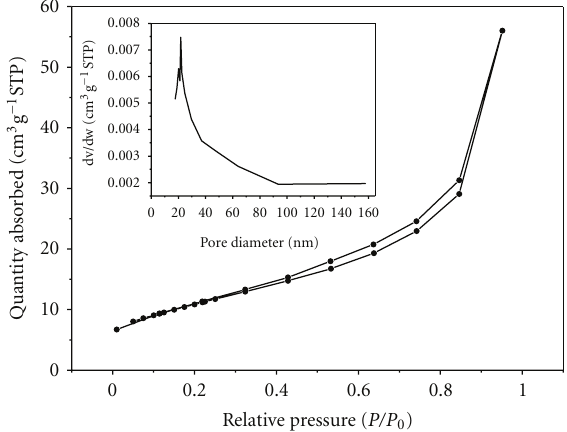
Figure 4: Nitrogen adsorption-desorption isotherm and pore size distribution curve (inset) of the as-prepared TiO 2 nanofibers ob- tained at 600 ◦